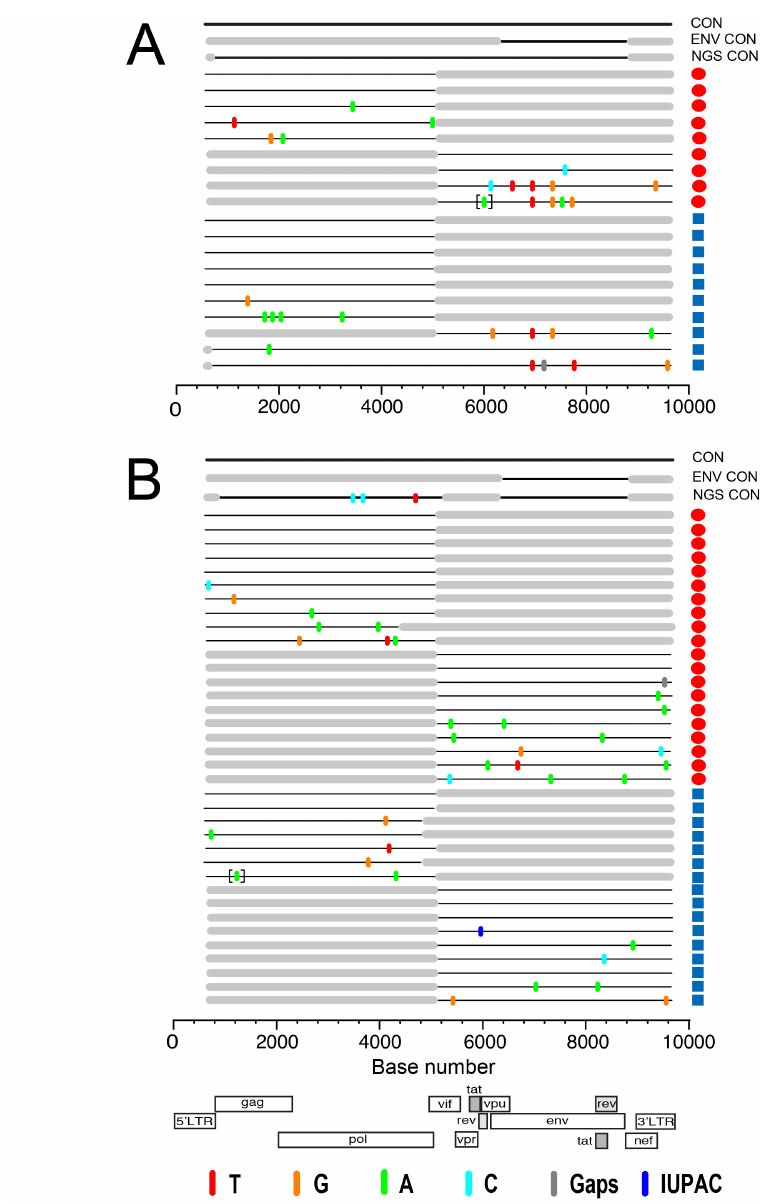
Figure 3 . Comparison of whole HIV-1 genomes from DBS by SGA and deep sequencing in two acute- ly infected subjects. Half- and full-genome HIV-1 sequences derived from DBS (red circles) and plasma (blue squares) from subjects T8250 (A) and N8261 (B) are aligned to a patient-specific consensus mas- ter sequence from SGA sequences (top line), gp160 env sequences (second line from top), and 454 deep sequences (third line). Colored tics and brackets are as defined in Figure 2. Flanking gray boxes indicate regions not amplified, while gray tics indicate intergenomic deletions. The horizontal axis indicates nucle- otide positions based on HXB2 reference sequence numbering. The HIV-1 genome cartoon at the bottom depicts the flanking LTRs and 9 canonical protein-coding